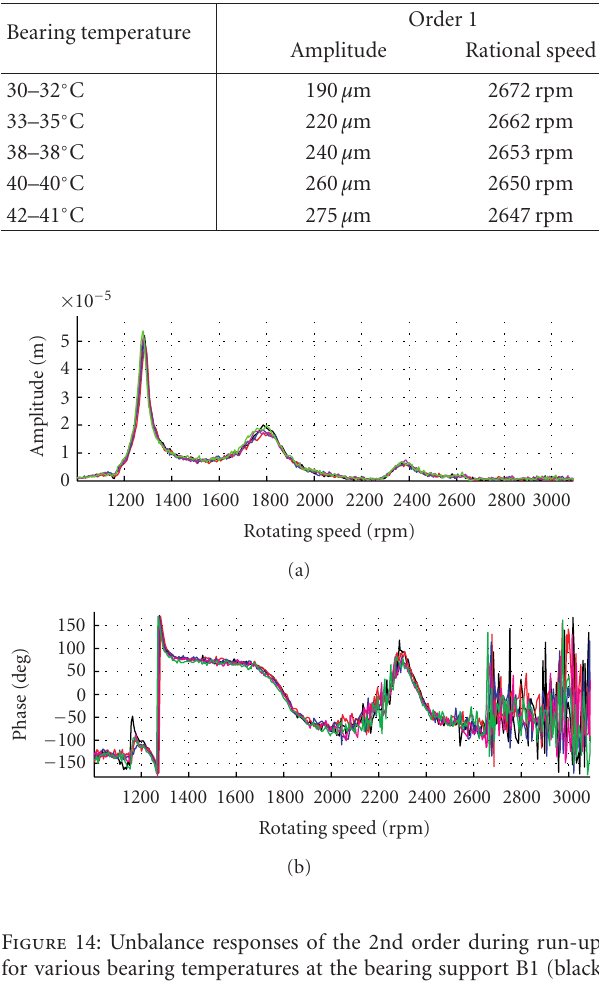
Table 1: Amplitudes and critical speeds at the bearing support B1 for run-ups.